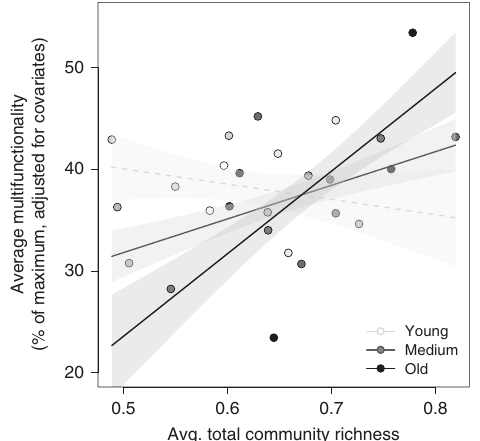
Fig. 4 Overall multidiversity effects on average multifunctionality. Effects of average total community richness (average of standardized species richness across trophic levels, including tree species richness) on multifunctionality as the average of nine standardized ecosystem functions. Solid regression lines (model predictions for young (40 years), medium (70 years), and old (100 years) forest stands) indicate signi fi cant ( P ≤ 0.05) relationships. The broken line indicates nonsigni fi cant relationships. Note that y -axis values show data adjusted for covariates (see Supplementary Fig. 7a for raw data). Regression lines ( ± 1 SE, fi tted across all 26 plots) are adjusted for covariates and indicate signi fi cant ( P ≤ 0.05) relationships. The stand age of the study plots ( n = 26) is indicated by a continuous gradient from white (youngest plots ~20-year- old) to black (oldest plots > 80-year-old); avg. average